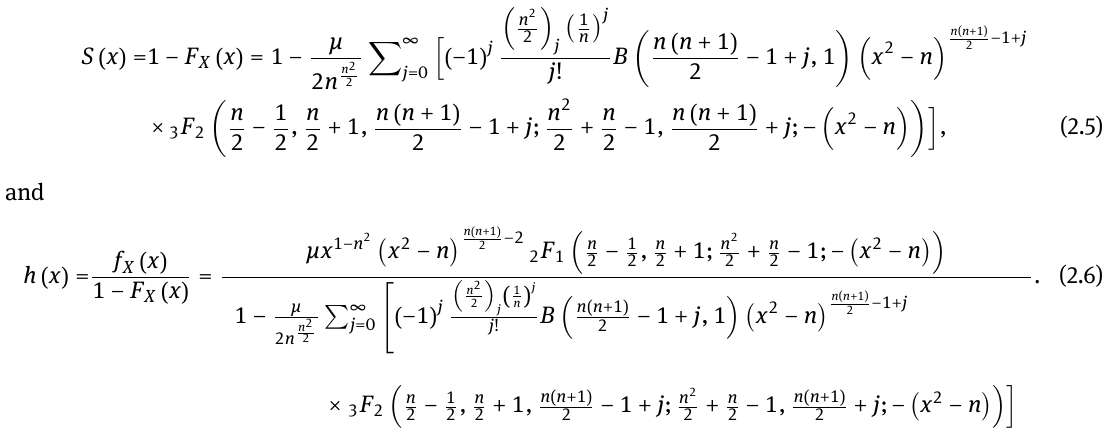
Figure 3: Plots of the survival function, S ( x ) , for n = 2 ,